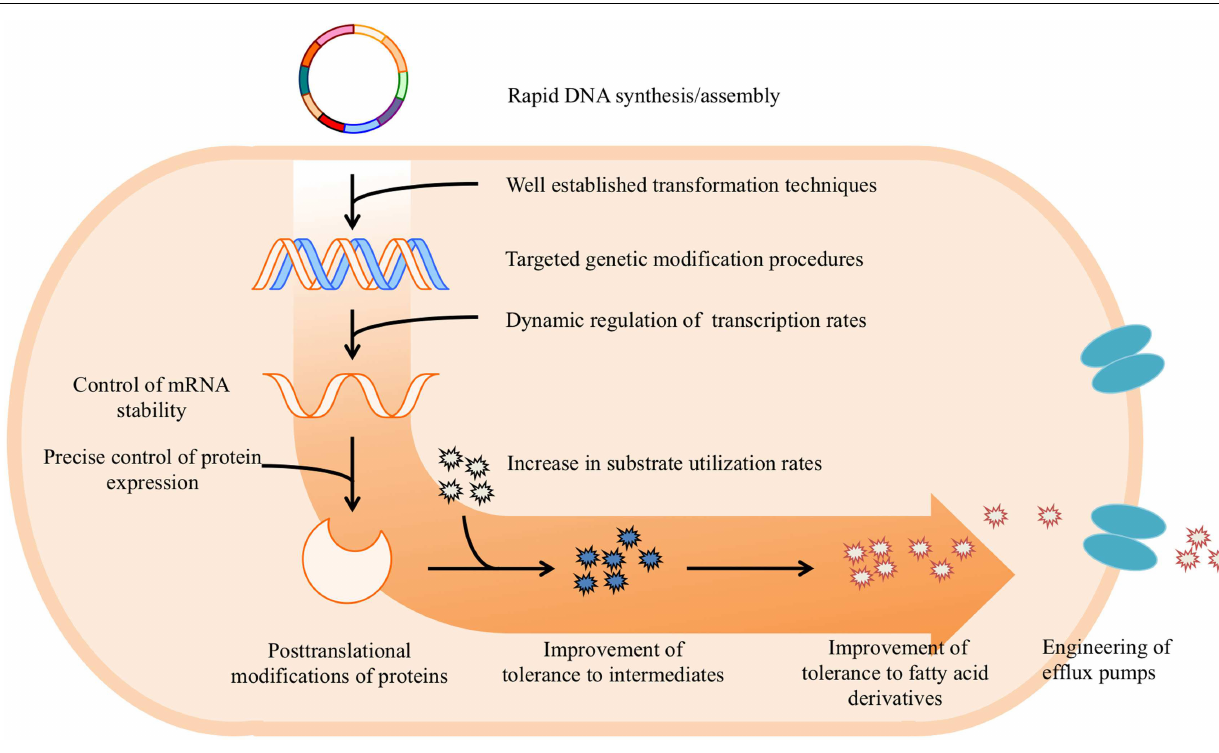
FIGURE 2 | Overview of potential applications of synthetic biology tools for construction and optimization of metabolic pathways that increase production of fatty acid-derived chemicals